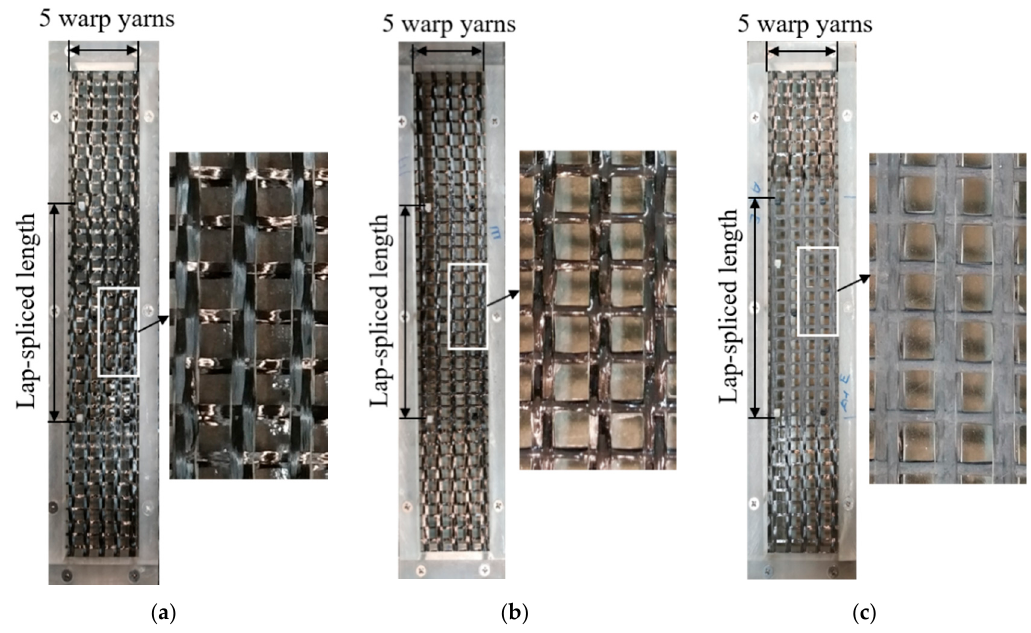
Figure 3. Photos of carbon fiber mesh with different coating treatments: ( a ) carbon fiber mesh (without surface treatment); ( b ) carbon fiber mesh impregnated by epoxy; ( c ) carbon fiber mesh coated with aluminum oxide powder after epoxy impregnation.